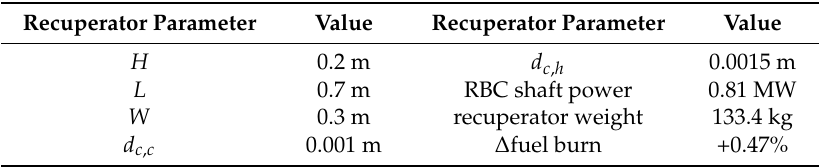
Table 8. Parameters of the final recuperator design at